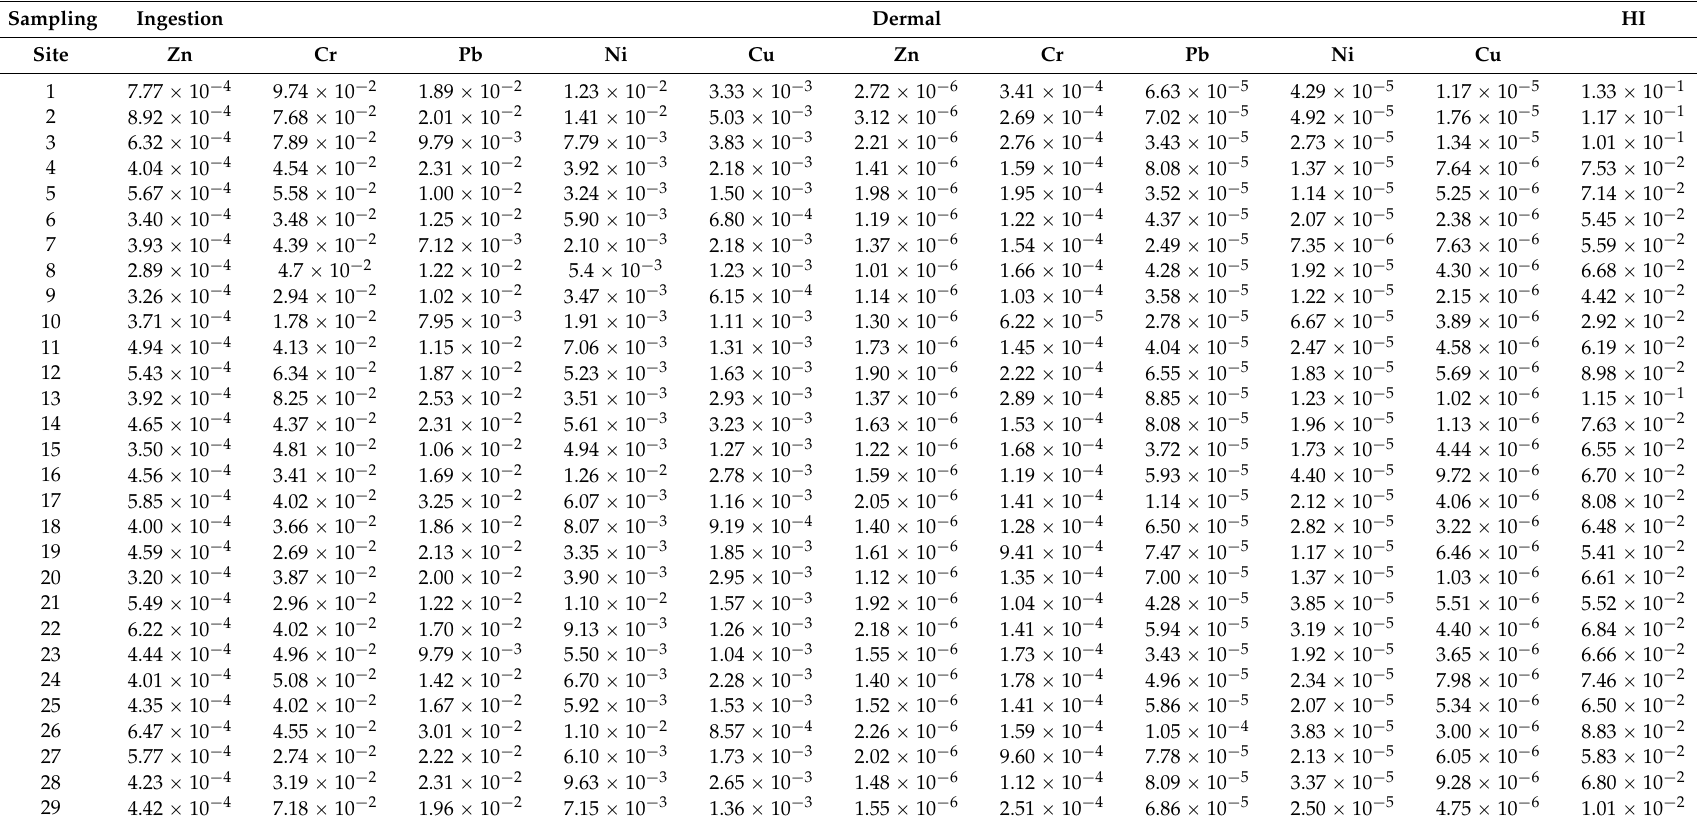
Table 5. Human health risks of five heavy metals in bed sediment of National Scenic Area Songhuahu (NSAS). Sampling